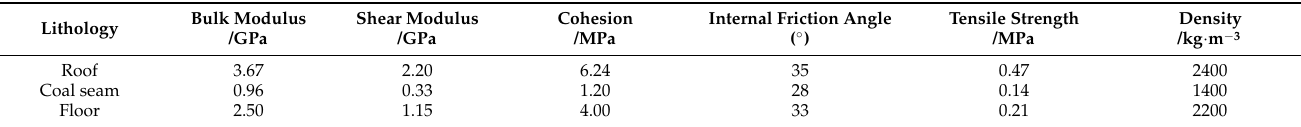
Table 4. Mechanical parameters of coal seam and rock layers.